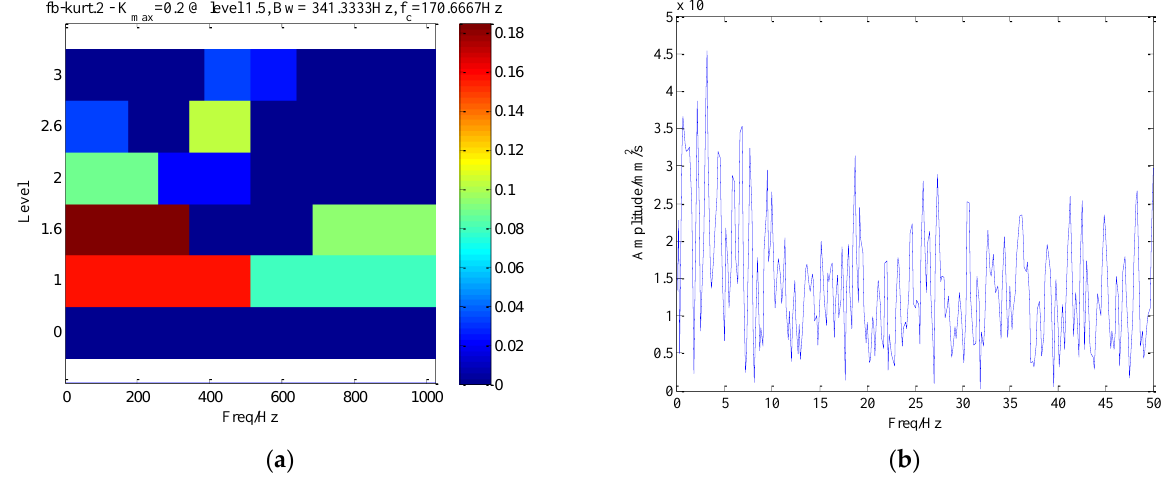
Figure 21. Result using spectral kurtosis: ( a ) band partition and ( b ) envelope spectrum.